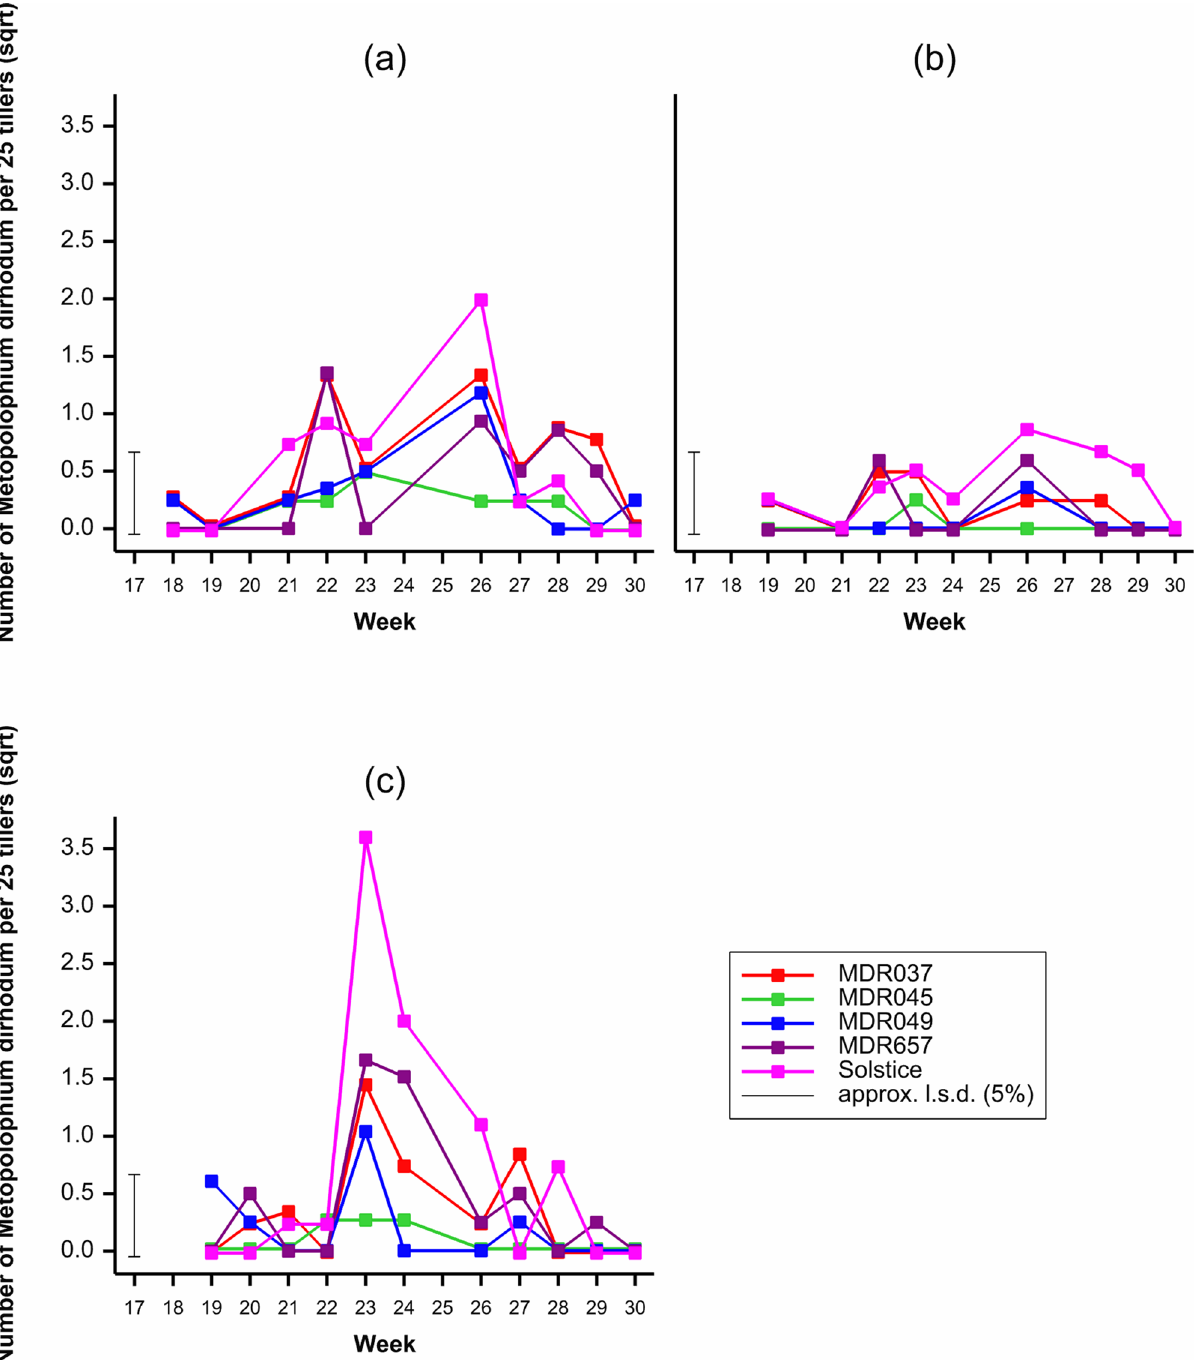
Figure 3. Average number of Metopolophium dirhodum per 25 tillers observed on Triticum aestivum Solstice, Triticum moncoccum MDR037, MDR657, MDR045 and MDR049 in field trial ( a ) Year 1 (2017), ( b ) Year 2 (2018), ( c ) Year 3 (2019) from week 18 to week 30. All data was subject to square root Temperature and rainfall during field trials. Data on temperature and rainfall across the three sum- mer field trials was obtained from the Rothamsted Long-term Experiments National Capability (LTE-NCG) e-Rothamsted Archive. The highest temperatures and the least rainfall were recorded in 2018 (field trial year 2) (Table 1). Week averages of meteorological data are available in Supplementary Material. Simple linear regressions were carried out to determine if observed aphid populations and presence of natural enemy densities were correlated with meteorological factors maximum temperature, minimum temperature, rainfall, and rainfall duration.